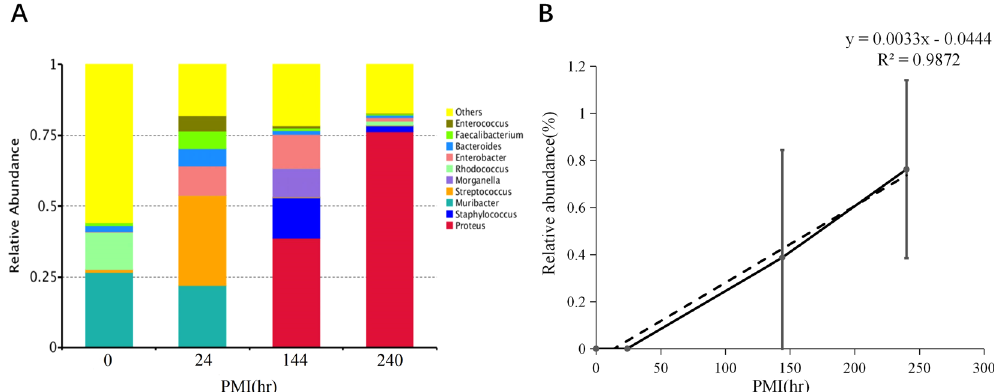
Figure 6. ( A ) Relative abundance of genera of bacteria with different PMI. ( B ) Relative abundance changes of Proteus had strong positive linear relationship with PMI.